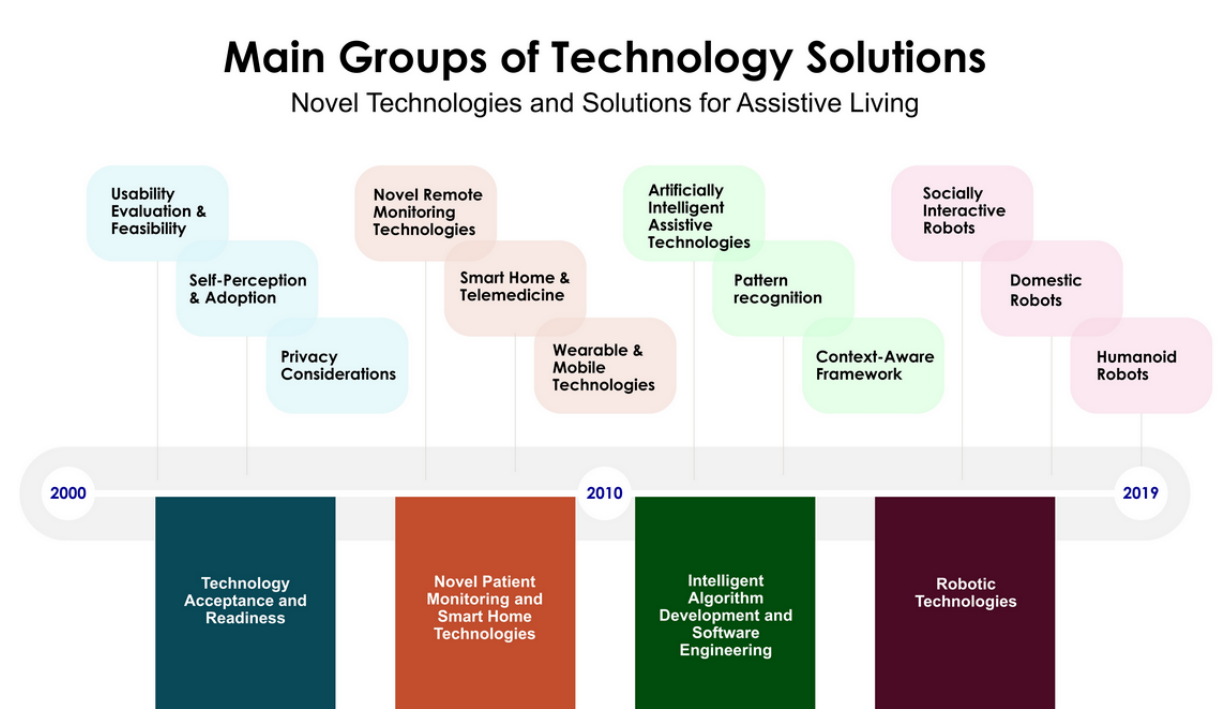
Figure 4. Technology solutions for elderly